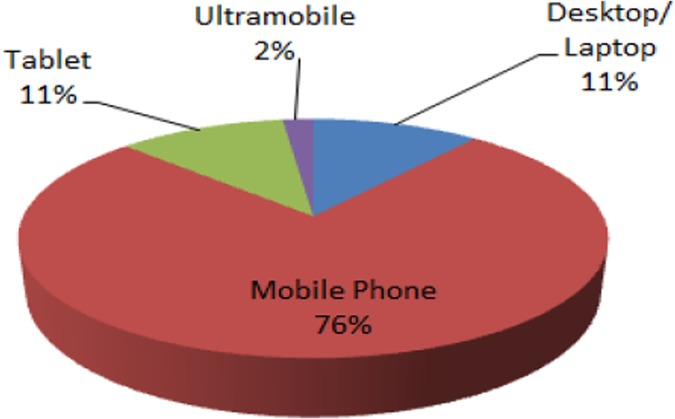
Worldwide device shipments in year 2014[3].